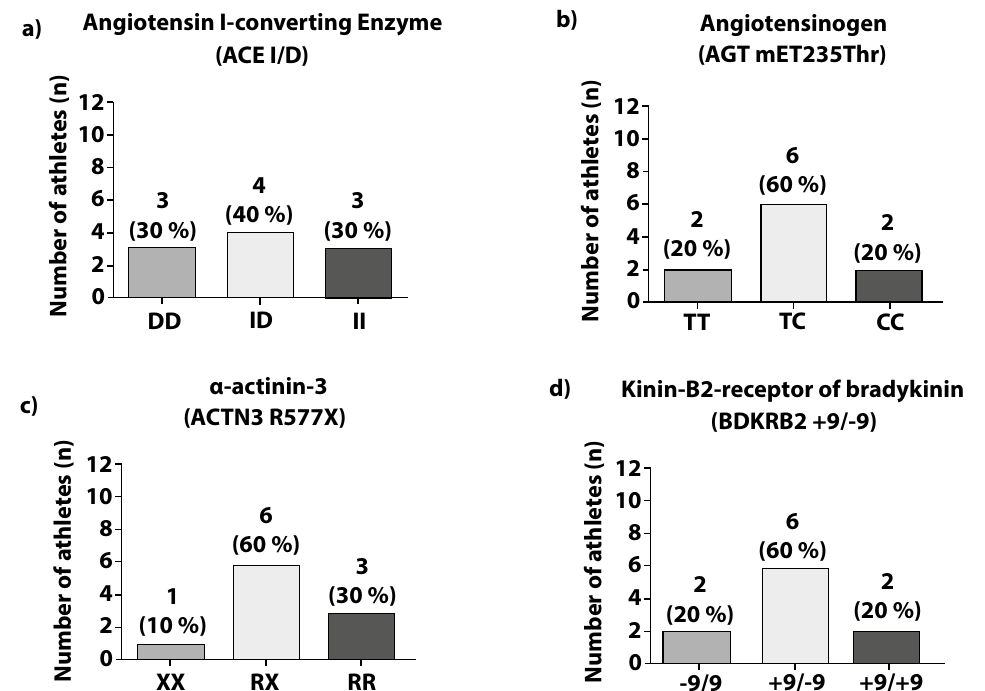
Figure 2. Slalom kayakers genetic profile; a) Gene polymorphisms of angiotensin I-converting enzyme (ACE). DD, ID and II indicate expression absence, less expression and high expression, respectively; b) Gene polymorphisms of angiotensinogen (AGT). TT, TC and CC indicate expres - sion absence, less expression and high expression, respectively; c) Gene polymorphisms of α-actninin-3 (ACTN3). XX, RX and RR indicate expression absence, less expression and high expression, respectively; d) Gene polymorphisms of kinin-B2-receptor of bradykinin (BDKRB2). -9/-9, +9/-9 and +9/+9 indicate expression absence, less expression and high expression, respectively.